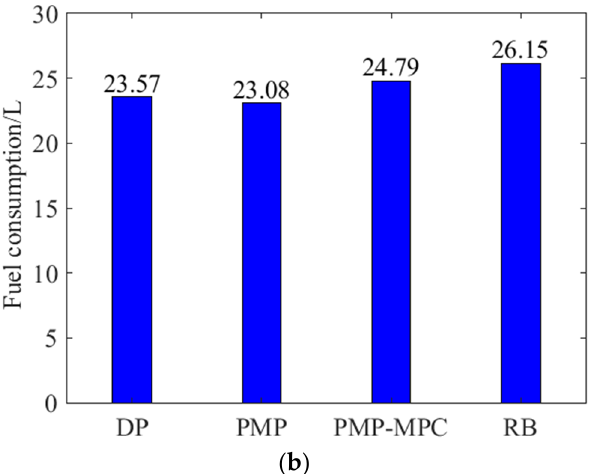
Figure 15. Fuel consumption for different methods. ( a ) Fuel consumption for different methods in driving cycle A. ( b ) Fuel consumption for different methods in driving cycle B.